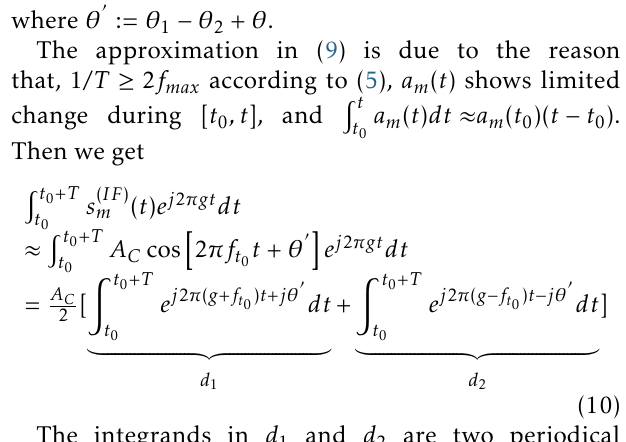
Figure 2. Basic procedures of the proposed WMUE attack detection scheme.